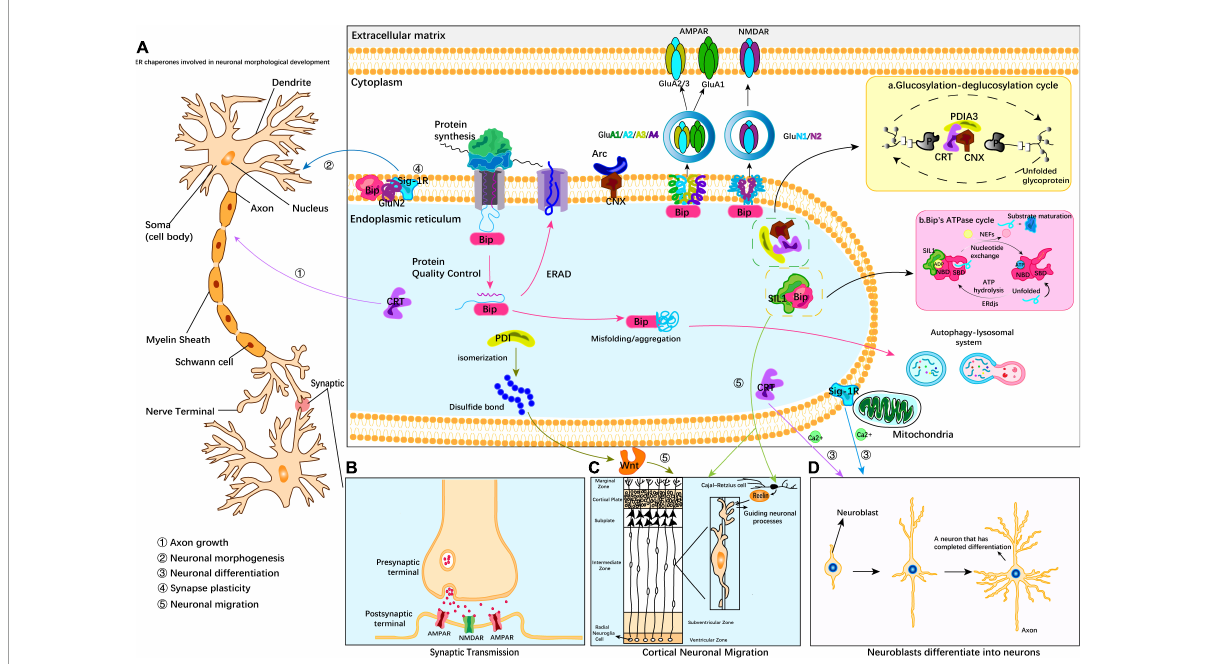
FIGURE1 Endoplasmic reticulum (ER) molecular chaperones involved in neurodevelopment. ER molecular chaperones regulate central nervous development through two mechanisms: 1. ER chaperones directly act on specific developmental periods and regulate developmental stages. 2. ER chaperones indirectly act on secretory proteins or receptor proteins and regulate ER stress by ensuring protein homeostasis. CRT and Sig-1R regulate neuronal morphogenesis and dendritic axon growth (A) ; Bip, SIL1, and PDI-1 regulate cortical neuron migration (C) ; CRT regulates Ca 2 + to guide NGF differentiation into mature neurons (D) ; Bip, CNX, and Sig-1R regulate synaptic function (B) . Indirect regulation mainly affects the secreted protein Reelin and AMPA and NMDA membrane receptors (C) , which act on the post-synaptic membrane and nerve migration. Bip proteins are involved in endoplasmic quality control and transport misfolded proteins for degradation, thereby maintaining protein homeostasis under ER stress conditions. Insert (a) CRT cooperates with CNX and PDIA3 to form the CNX/CRT cycle that controls protein folding within the ER. The CNX/CRT cycle can specifically recognize glycoproteins linked by N2 glycosidic bonds and regulate Ca 2 + homeostasis and Ca 2 + signaling processes in the ER. Insert (b) Bip is involved in a variety of ER functions dependent on ATP-induced conformational changes. The adenosine triphosphatase (ATPase) cycle of Bip is regulated by its co-chaperones of two families, namely, the ER-localized DnaJ-like proteins (ERdjs) and the nucleotide exchange factors (NEFs). ERdjs enables Bip to stably associate with its target protein. The NEF SIL1 then mediates the release of the target protein from the upper Bip and further folds to form the mature protein. Modified from Fucikova et al. (2021), Ichhaporia and Hendershot